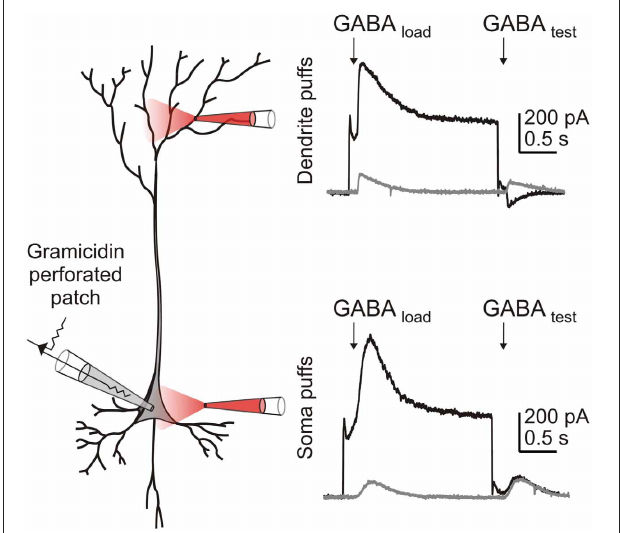
FIGURE 2 | Intense GABA A R activation results in Cl − accumulation more readily in smaller volume compartments of the cell, than in larger volume compartments. A CA3 hippocampal pyramidal cell within a P14 hippocampal slice culture was patched using the gramicidin perforated patch technique. HCO − 3 was excluded from the external solution to ensure that GABA A R currents were purely attributable to Cl − . GABA A R activation was evoked by local application of 100 μ M GABA to either the dendrites (top) or soma (bottom) of the neuron. In voltage clamp mode, Cl − was loaded by stepping the membrane voltage to − 37.5mV during application of the first “loading” puff (“GABA load”), before returning to − 60mV for the second “test” puff (“GABA test”). When the puffer pipette was positioned over the dendrites, a Cl − load affected the size and direction of the GABA A R current observed in response to the “test” puff. In contrast, this effect was not seen when a similar Cl − load was generated at the